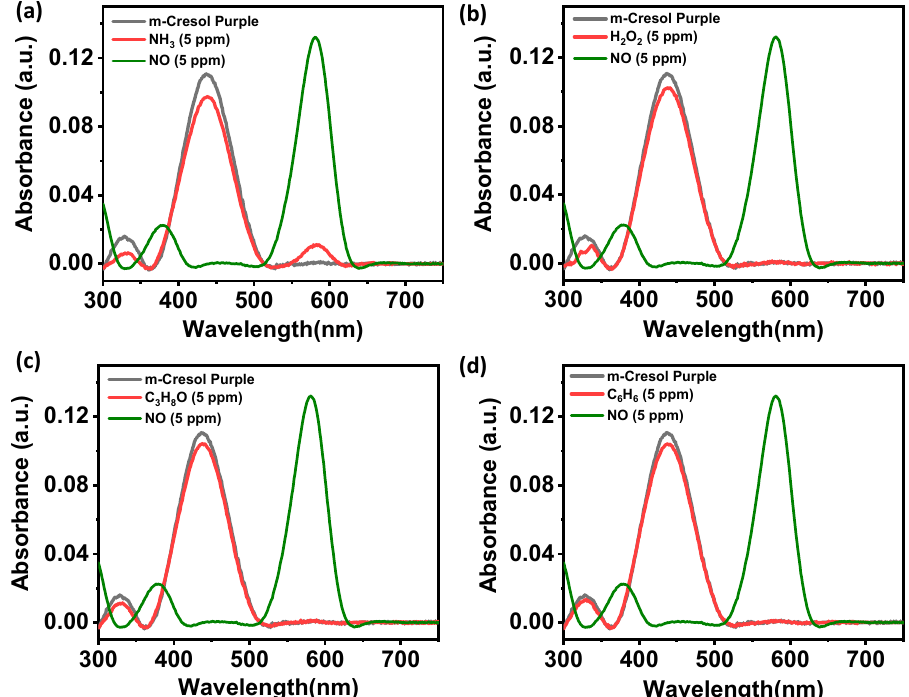
Figure 4. Selectivity analysis of m ‐ Cresol Purple dye. ( a ) Ammonia. ( b ) Hydrogen peroxide. ( c ) Isopropyl alcohol. ( d ) Benzene.